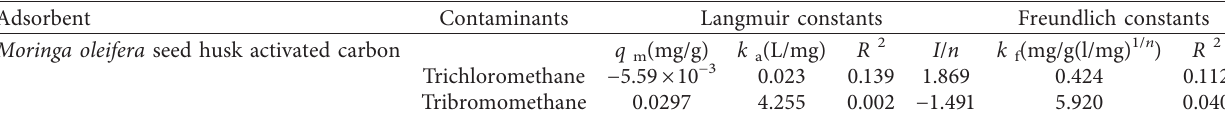
Table 7: Langmuir and Freundlich constants for the adsorption of trichloromethane and tribromomethane using Moringa oleifera seed husk activated